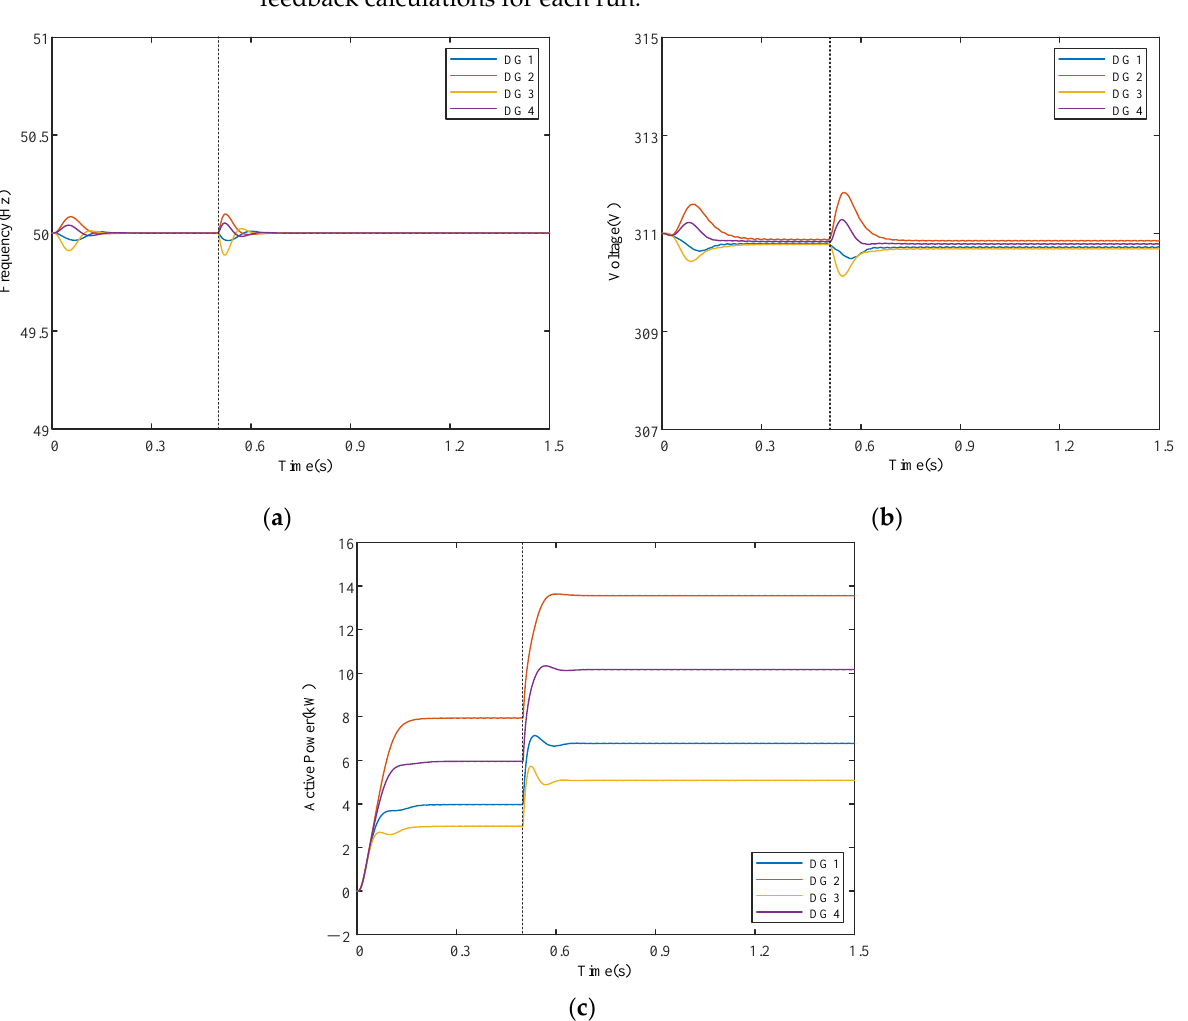
Figure 9. ( a ) Frequency output waveform; ( b ) voltage output waveform; ( c ) active power output waveform.